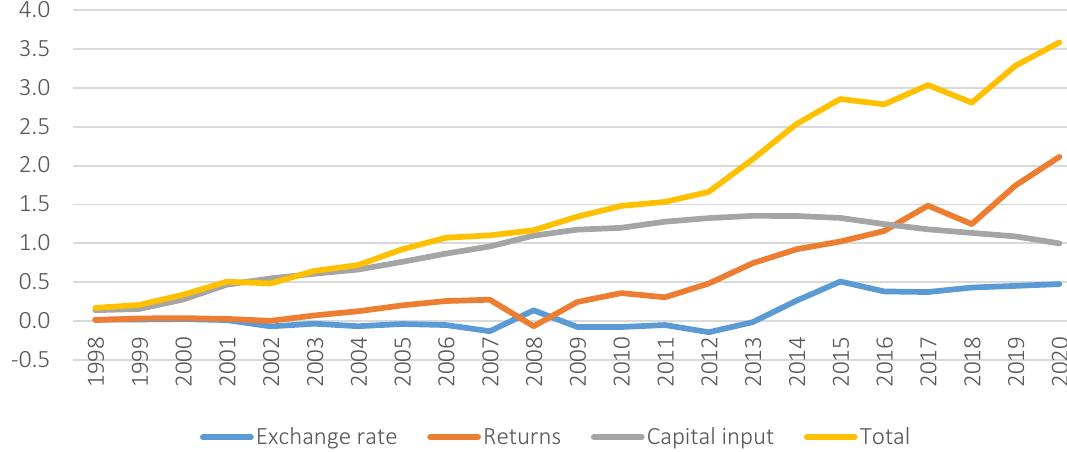
Figure 4. Value of the Norwegian Pension Fund – Global, ratio to mainland GDP